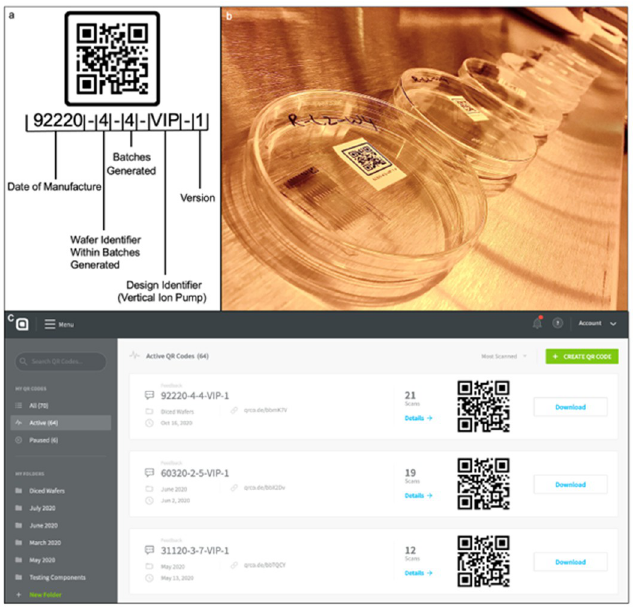
Fig 2. QR code tracking system. (a) A detailed breakdown of the unique identifier’s nomenclature that is tied to a QR Code, and (b) label device container with unique identifier and QR Code. (c) User interface subscription-based desktop application used to generate QR Code. Fig 2C provided through courtesy of QR Code Generator.